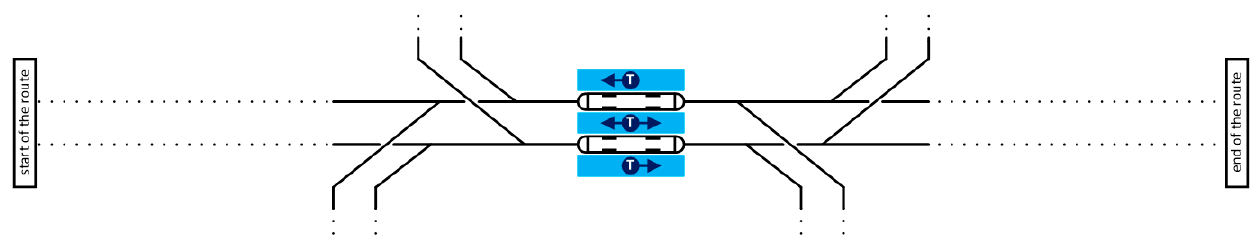
Figure 13. Using the bi-directional tram to serve tram stops located on side or island platforms.